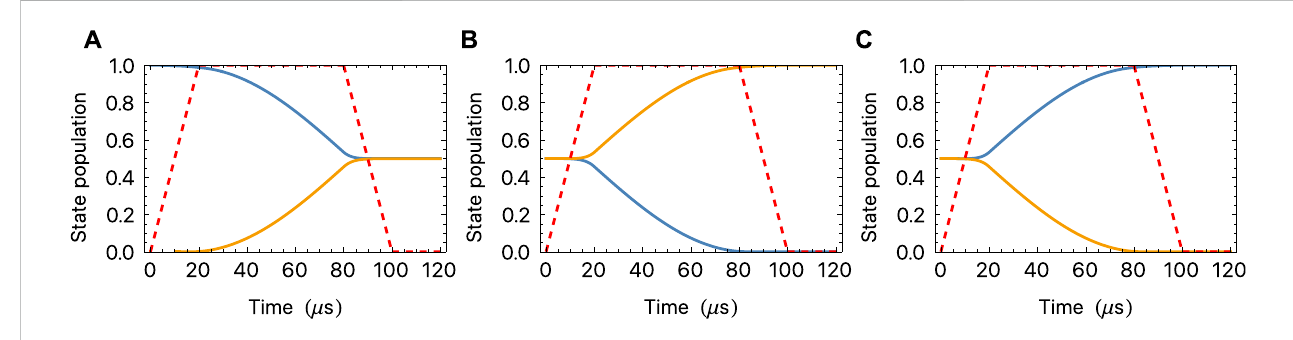
FIGURE 7 Dynamicswithinthe G =2manifoldof 173 YbFinducedbyapulseofmagnetic fi eldorthogonaltotheelectric fi eld,calculatedbynumericalsolutionofthe Schrödinger equation for all 10 levels shown in the upper half of Figure 2. Populations of the states M F = 5/2 (blue) and M F = − 5/2 (orange) as B x is ramped on andoffforatotaltimeof100 µs.Themaximumvalueofthe fi eldis5.9 mTanditsamplituderelativetothismaximumisshownbythedashedredline. (A) Initial state is |5/2, 5/2 〉 ; fi nal state is | + 〉 . (B) Initial state is | + 〉 ; fi nal state is |5/2, − 5/2 〉 . (C) Initial state is | − 〉 ; fi nal state is |5/2, 5/2 〉 .